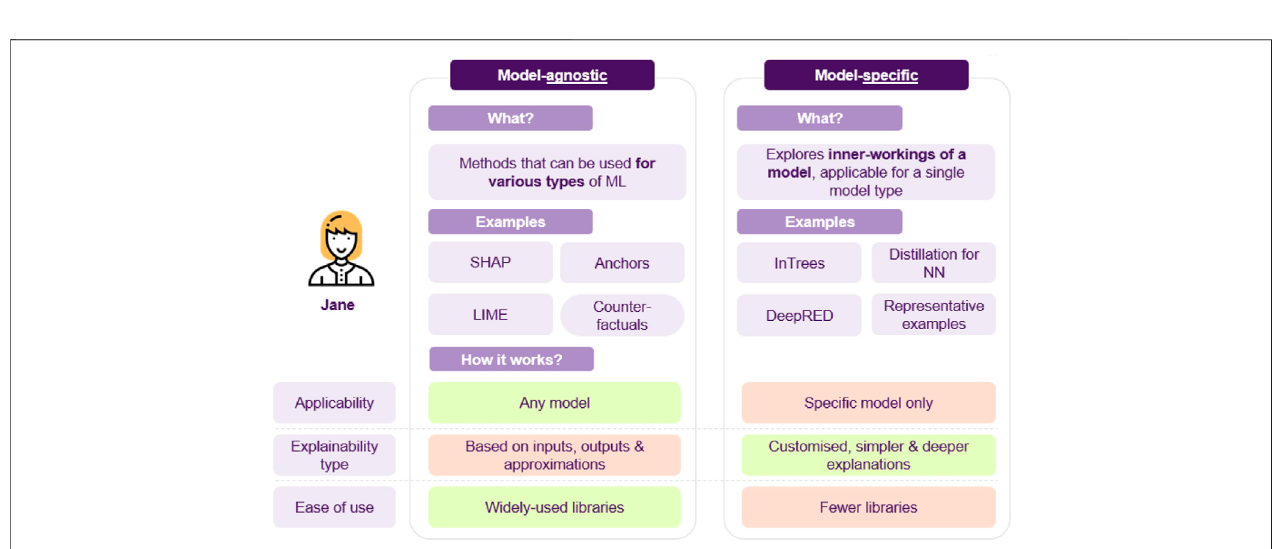
FIGURE 12 | A short comparison of model agnostic vs. model speci fi c approaches.